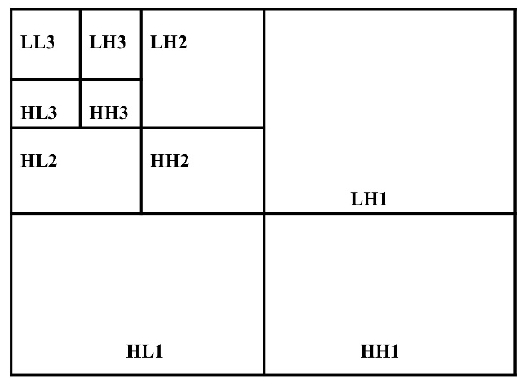
Figure 13. Three-level discrete wavelet decomposition.